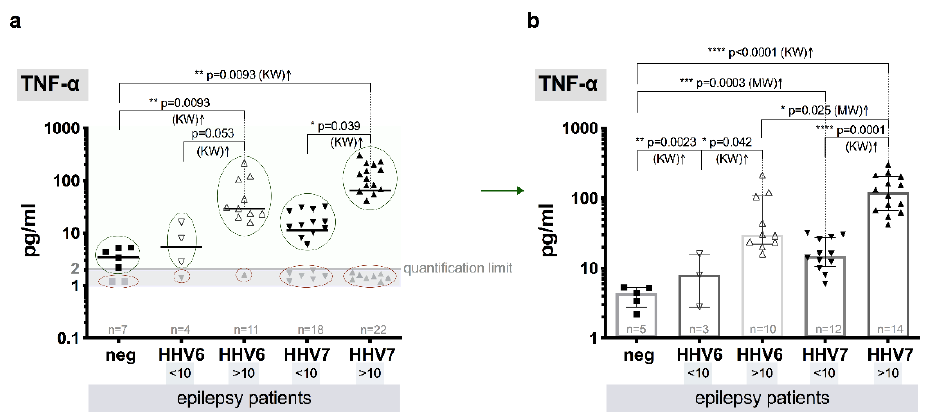
Figure 3. Comparative blood plasma level of TNF- α in epilepsy patients: ( a ) scatter plots with medians of HHV-6 and HHV-7 negative (neg) and HHV-6 and HHV-7 positive viral load ( < 10 and > 10 copies / 106 cells), gray symbols (marked with red ovals) show values below quantification limit (QL); ( b ) scatter plots with bars (medians with IQR) that represent values above QL (marked with green ovals in a) of HHV-6 and HHV-7 negative (neg) and HHV-6 and HHV-7 positive viral load ( < 10 and > 10 copies / 10 6 cells), values below QL are excluded; asterisks and respective p value represent significance level of di ff erences between the groups (KW—Kruskal–Wallis test).